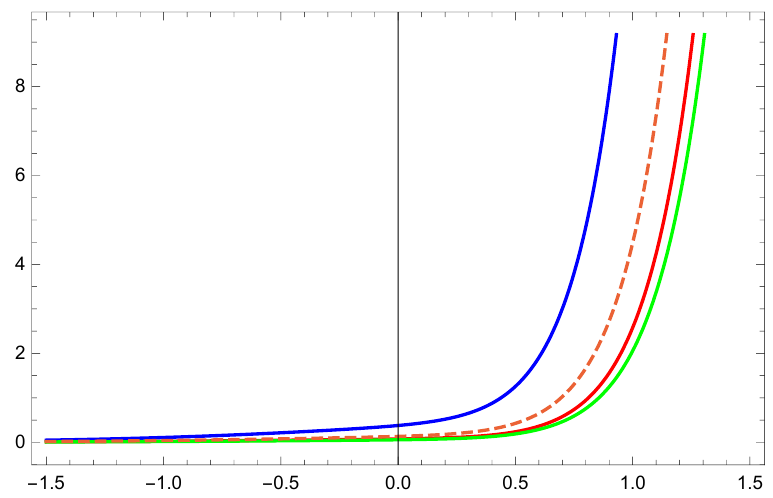
Figure 5 . Plots of slices of the potentials of the four di(cid:11)erent (cid:13)ux sets in [82] along the (cid:12)eld direction that satis(cid:12)es the